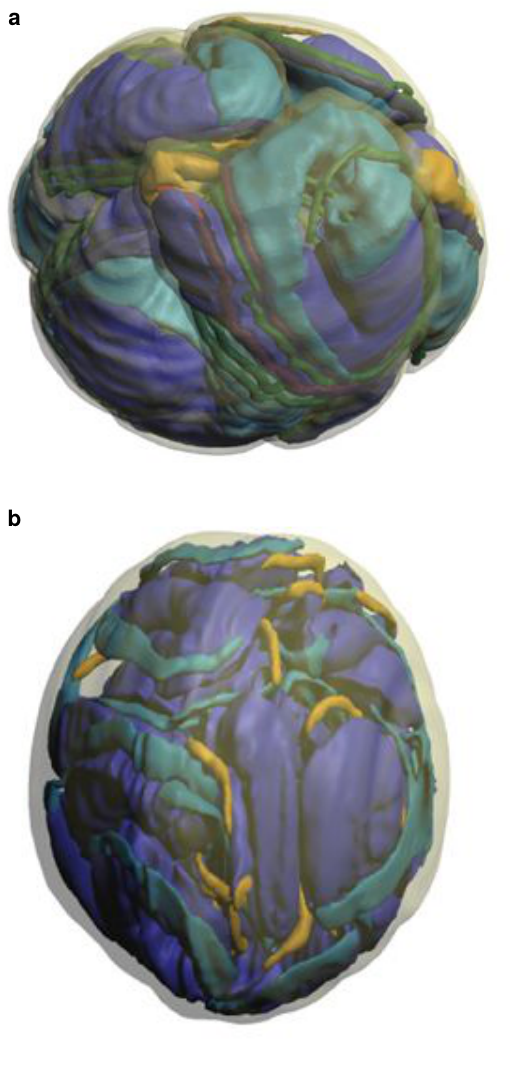
Surface renderings of spider sperm reconstructed based on digital tomography. a : Kukulcania hibernalis (Filistatidae), from Michalik and Ramírez (2014) with credit to E. Lipke (see Suppl. material 1). The PDF fi le of this article contains interactive 3D content. Click on the image to activate content and use the mouse to rotate objects. Additional functions are available through the menu in the activated fi gure. b : Orsolobus pucara (Orsolobidae), from Lipke et al. (2014) (see Suppl. material 2). The PDF fi le of this article contains interactive 3D content. Click on the image to activate content and use the mouse to rotate objects. Additional functions are available through the menu in the activated fi